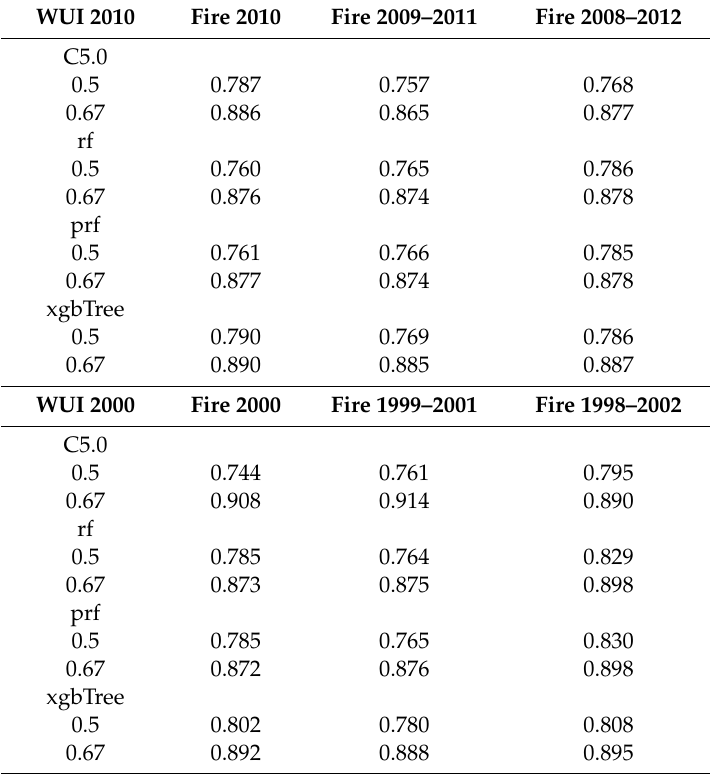
Table 1. Sensitivity (true positive rate) of predictions by four di ff erent classifiers (C5.0; rf = random forests, prf = parallel random forests, xgbTree = extreme gradient boosting with trees) and two prevalence ratios (0.5 and 0.67) for test set (25% of observations) based on modeled training data of